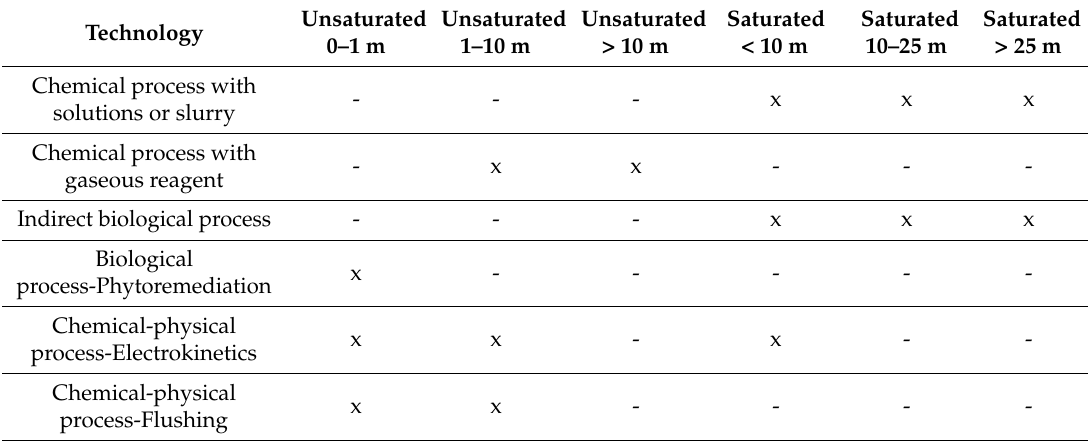
Table 1. Potential applicability (x: yes; -: no) of innovative technologies depending on the zone and maximum depth of soil to be